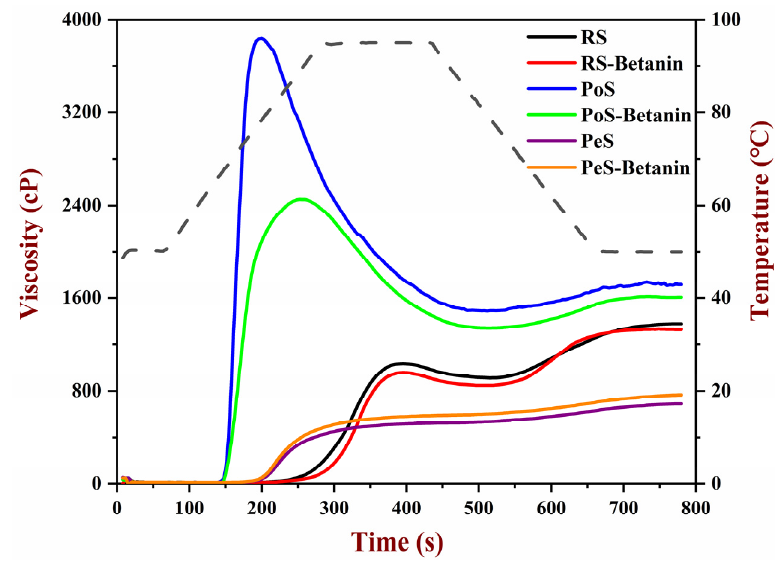
Figure 1. RVA pasting profiles of starches and starch–betanin samples. RS: rice starch; PoS: potato starch; PeS: pea starch. Table 1. Pasting properties of starches and starch–betanin samples.